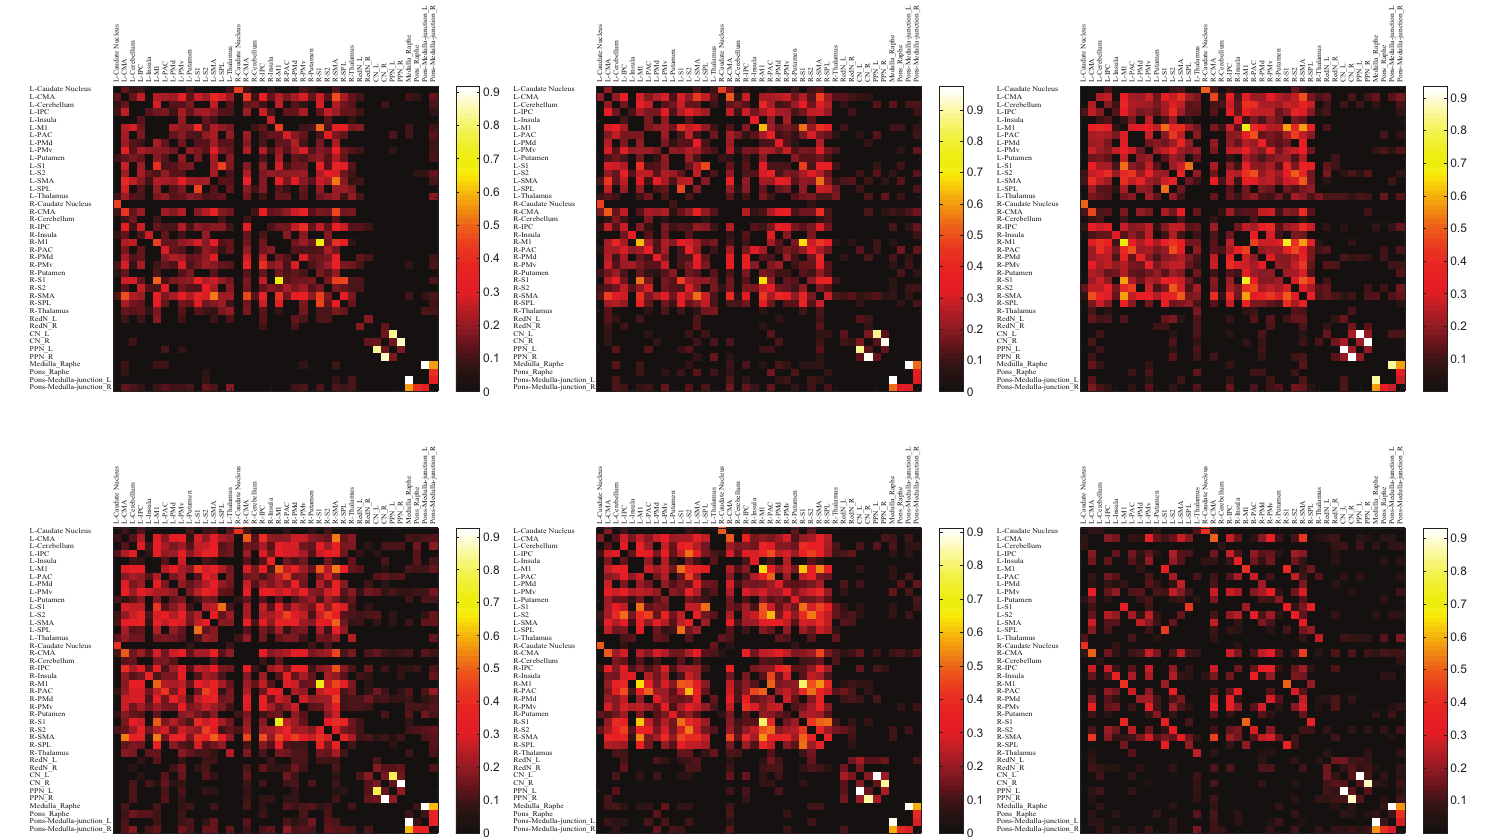
Figure 3. Matrix of edge magnitudes between all pairs of brain regions. The brightness of a grid represents the weight value of the edge between two nodes from the corresponding row and column. The color bar indicates Fisher-transformed correlation coe ffi cient values. Black grids indicate no existing links. The dark area in each network reflects sparser interaction between inside- and outside-brainstem